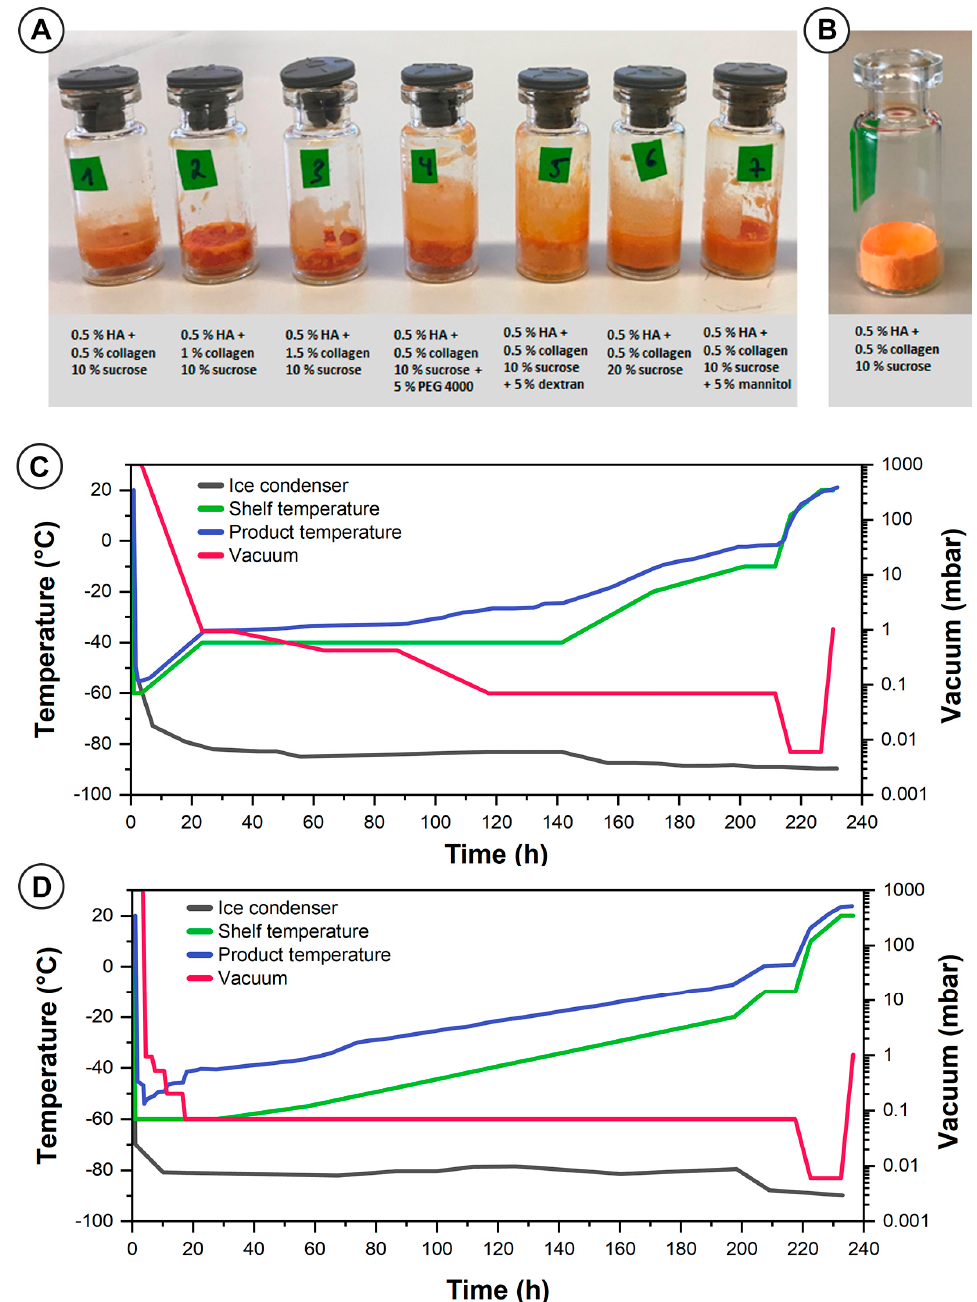
Figure 3. Representative examples of the freeze-dried collagen–hyaluronic acid hydrogels with rifampicin-loaded liposomes before ( A ) and after ( B ) process optimization together with the process records. After a first process optimization, the configuration ( C ) did not lead to a well-defined product irrespective of the addition of cryoprotectants and lyoprotectants. After further process optimization, a well-defined cake ( B ) was achieved. The final process parameters are also presented ( D ). Freeze–thaw studies were used to identify suitable cryoprotectants. Ozcelikkale et al. reported a destabilizing effect of freezing on collagen fibrils due to the considerable growth of ice crystals [28]. DMSO and PEG 400 were identified as potential stabilizers but did not provide any advantage in the subsequent freeze-drying process (Table 1C). After further process optimization, we increased the number of intermediate steps to reduce the vacuum from 0.94 mbar to 0.07 mbar, along with a gradual increase in the shelf